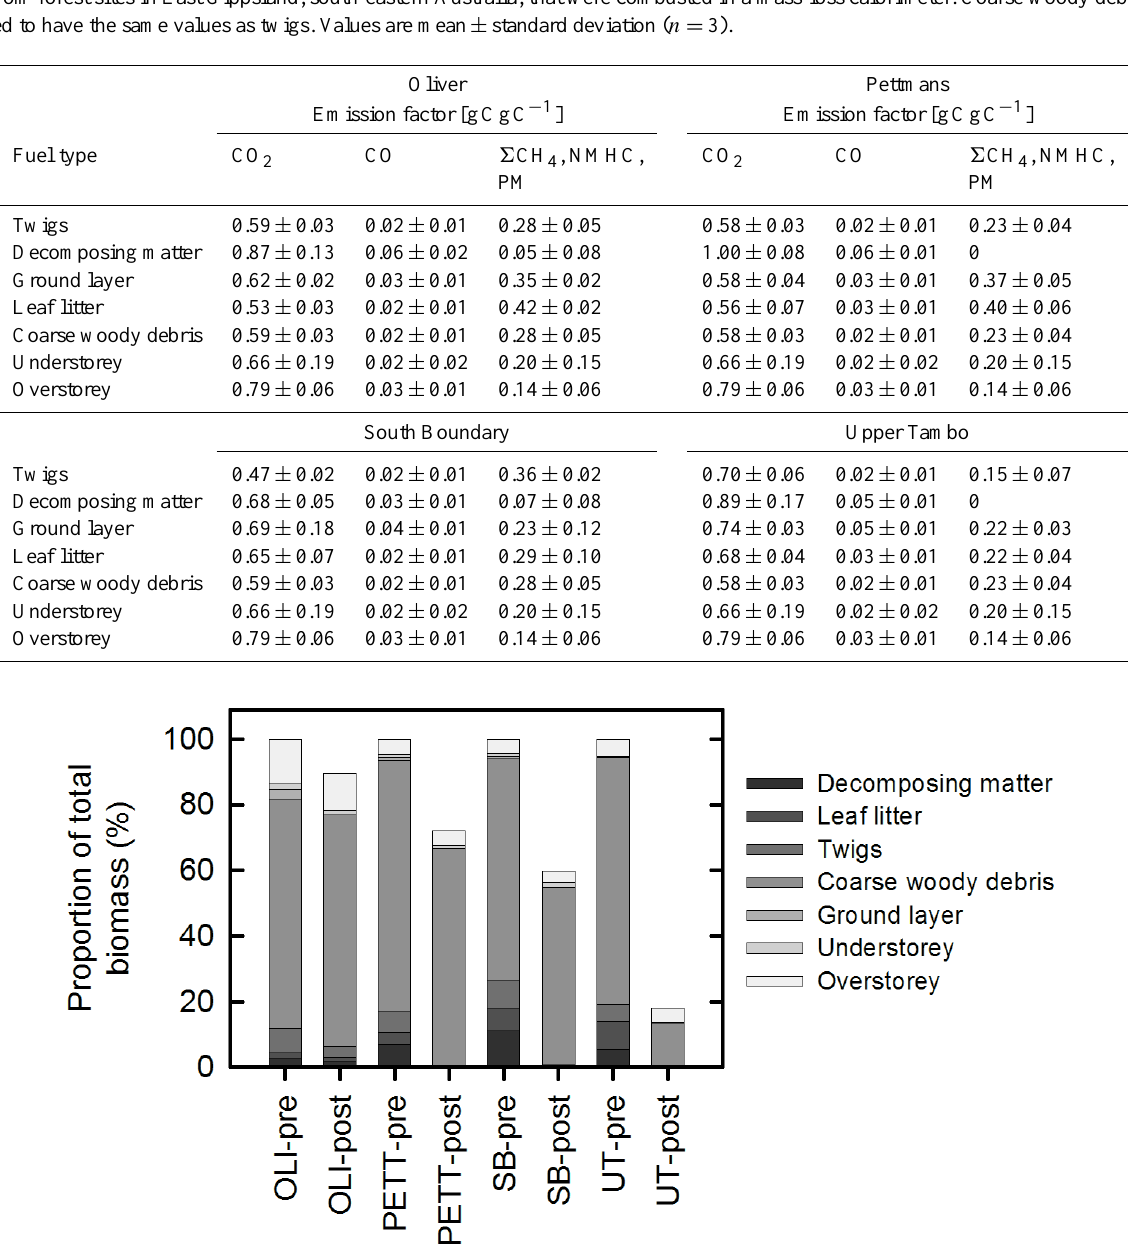
Figure 2. Proportion of the total biomass for each fuel type, at each site, before and after planned burning. The sites are Oliver (OLI), Pettmans (PETT), South Boundary (SB) and Upper Tambo (UT). Each section of each bar represents the mean proportion measured from three plots within each site. “Pre” and “post” refer to measurements made before and after the planned